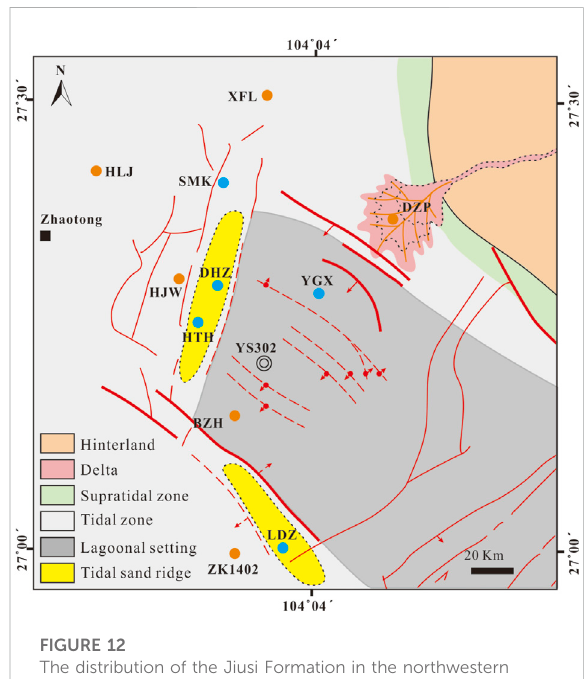
FIGURE 12 The distribution of the Jiusi Formation in the northwestern Weining